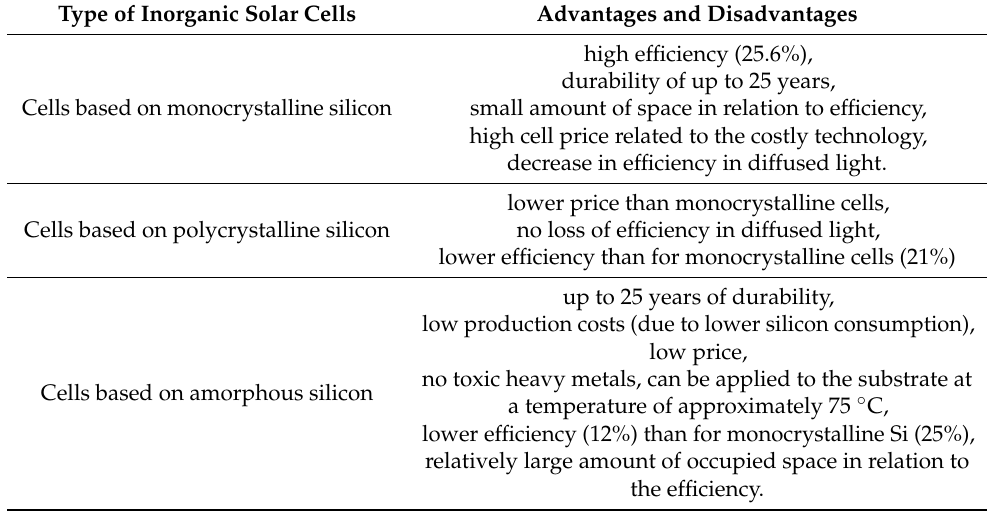
Table 3. The advantages and disadvantages of selected inorganic solar cells. Type of Inorganic Solar